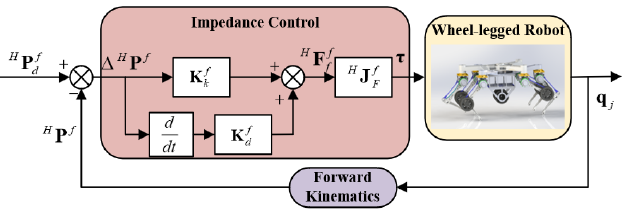
Figure 5. Control block diagram of the swing phase. The sub-block of impedance control calculates the torque of joints to make the swing leg move smoothly and stably.